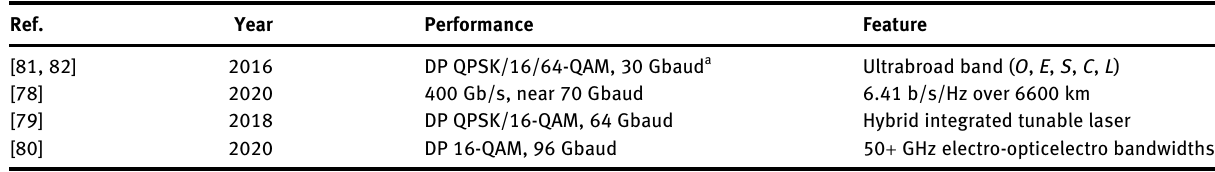
Table  : Recent demonstrations of integrated silicon coherent optical transceivers. Ref.